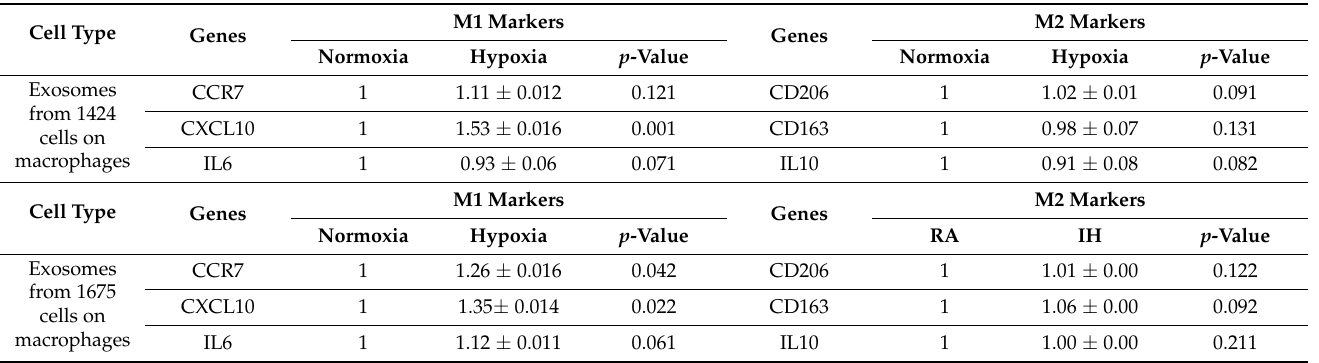
Table 4. Exosomes derived from melanoma 1424, and 1675 cells exposed to normoxia and intermittent hypoxia and applied into THP1